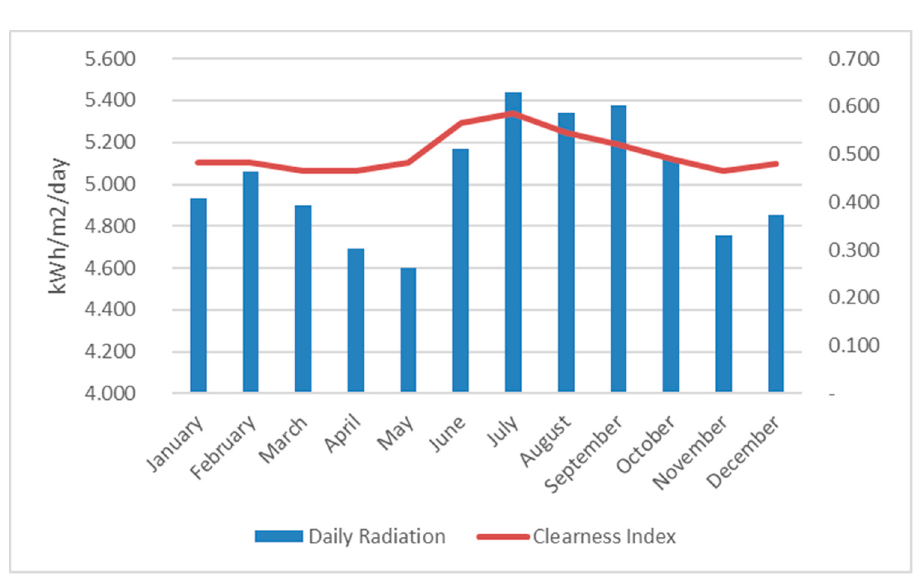
Figure 6. Scheme of the Hybrid mini-grid. The considered PV system and replacement cost is 2,200 $/kW p . The O & M cost is set to 10 $/kW p /year. The solar module type is a polycrystalline PV panel with efficiency 15%. Costs include purchase, transportation and installation of modules, all balance of system components like cables and structures (excluding the inverter) and the security system. The cost of the inverter is set to be 300 $/kW, and the efficiency is assumed to be 95%. For the BESS the authors consider a Li-Ion battery, with round trip losses of 8%, an estimated cost of 600 $/kWh, an O & M cost of 10 $/kWh/year, and a connection on the DC bus [14]. The cost of the diesel Generator is set to 500 $/kW and the fuel price is set to 1.4 $/l, data collected during the site visit. The optimal configuration proposed by Homer is formed by 29.4 kW p PV generator, with a 15 kW converter, a 110 kWh BESS, and a 36 kW diesel generator.